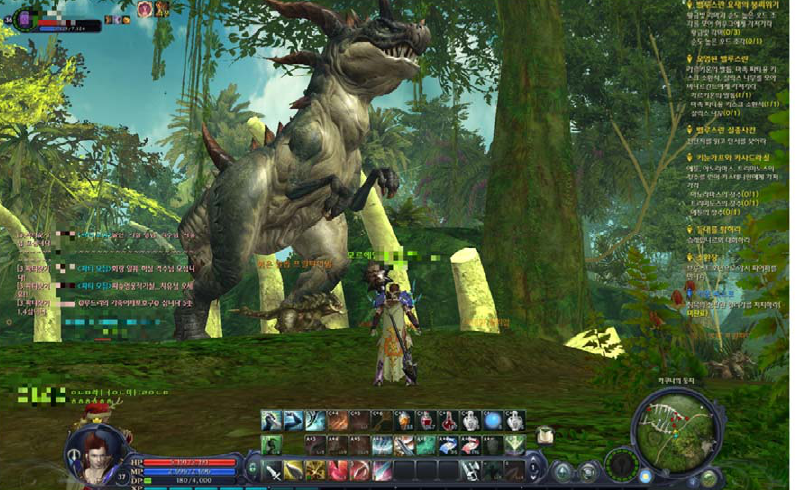
Figure 1. An in-game screen shot from AION, a popular MMORPG. AION’s design puts heavy emphasis on cooperation for success in gaming, generating rich and detailed data of collaborative human interactions. Copyright NCSoft, Inc.